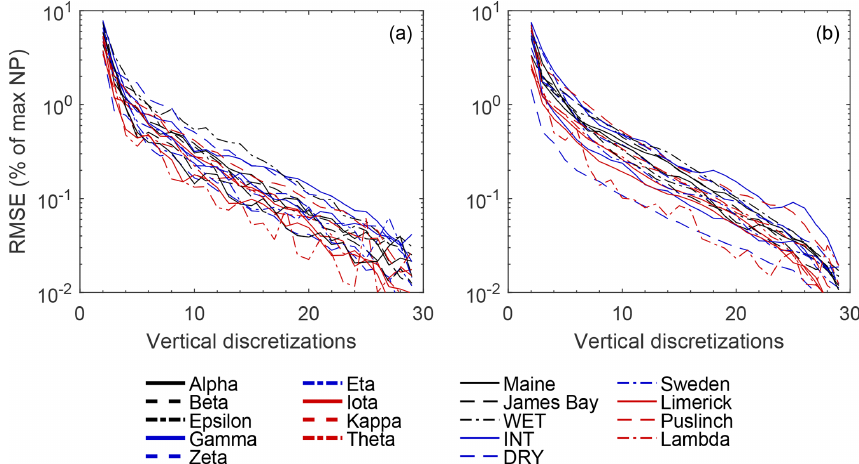
Figure 10. Difference in plot-scale potential net photosynthesis (NP pot – as a percentage of max) based on a coarse to fine discretization of elevation values ( n z = 2 to 30) (see Fig. S13 for example). NP pot is modeled using separate parameterizations (see Fig. S5) for each microtopography class (a) , as well as a uniform (low-hummock) parameterization across microtopography classes (b) . RMSE was calculated using NP pot from the original plot-level DEMs as the reference values. Discretized elevation values for each plot are based on elevation + 50 percentiles ( p z,i ) , where p z,i = (i − 1 ) 100 , for i = 1 to n z n z n z